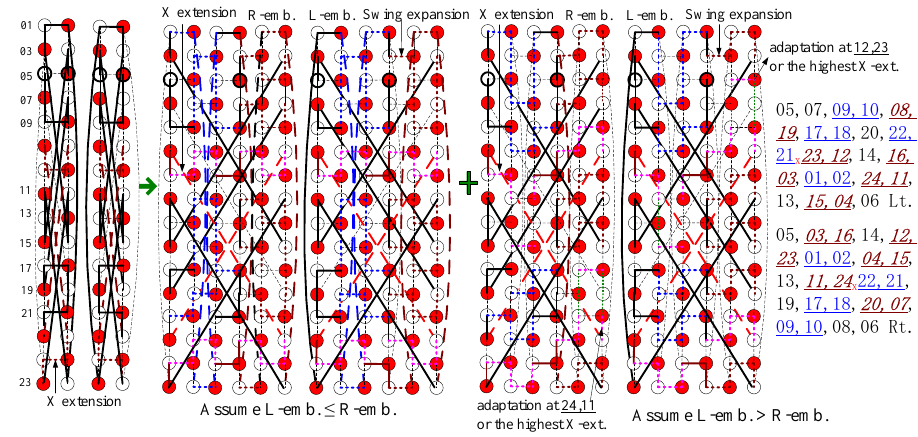
Figure 4. MIHP performance may exist in HT(2)/GHT(2, 12,